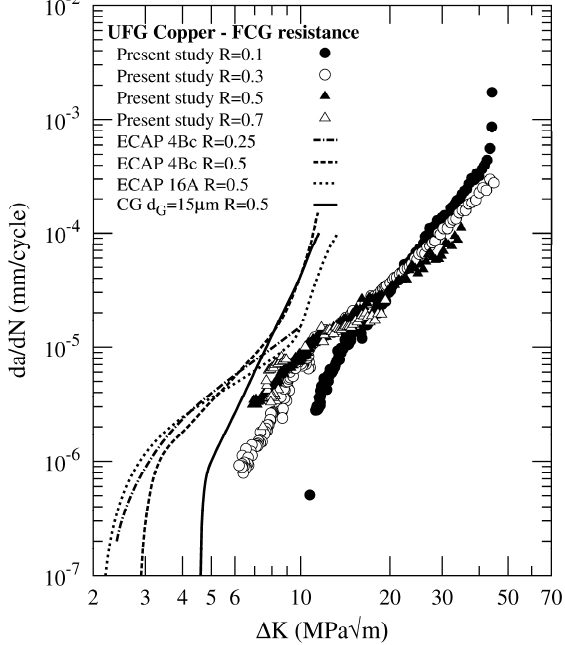
Figure 14: Fatigue crack growth curves for 8-ECAPed UFG